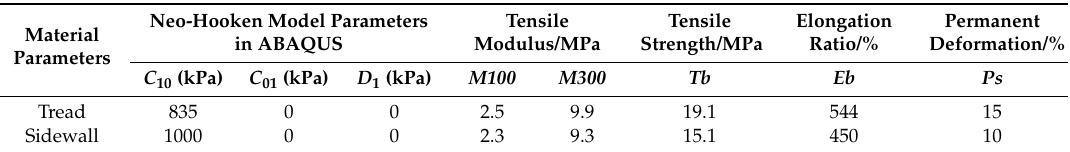
Table 1. Tire rubber material parameters.